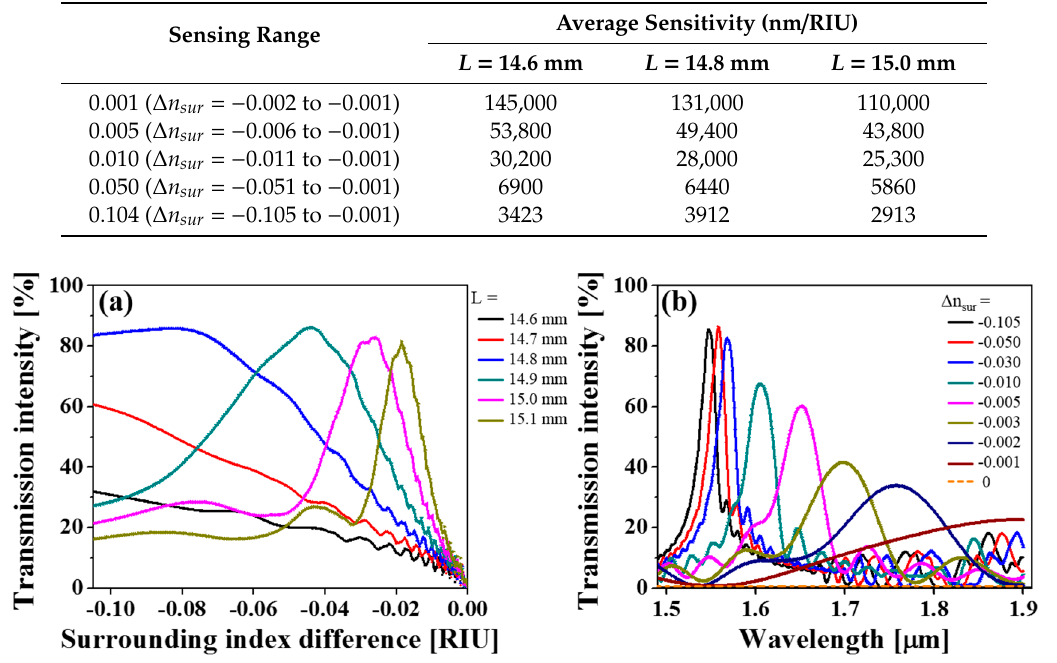
Figure 5. ( a ) Calculated transmission curves for the proposed sensor as a function of the surrounding index difference at λ = 1550 nm under different interaction lengths and ( b ) its spectral responses based on an SMF (980-HP) with L = 14.8 mm.